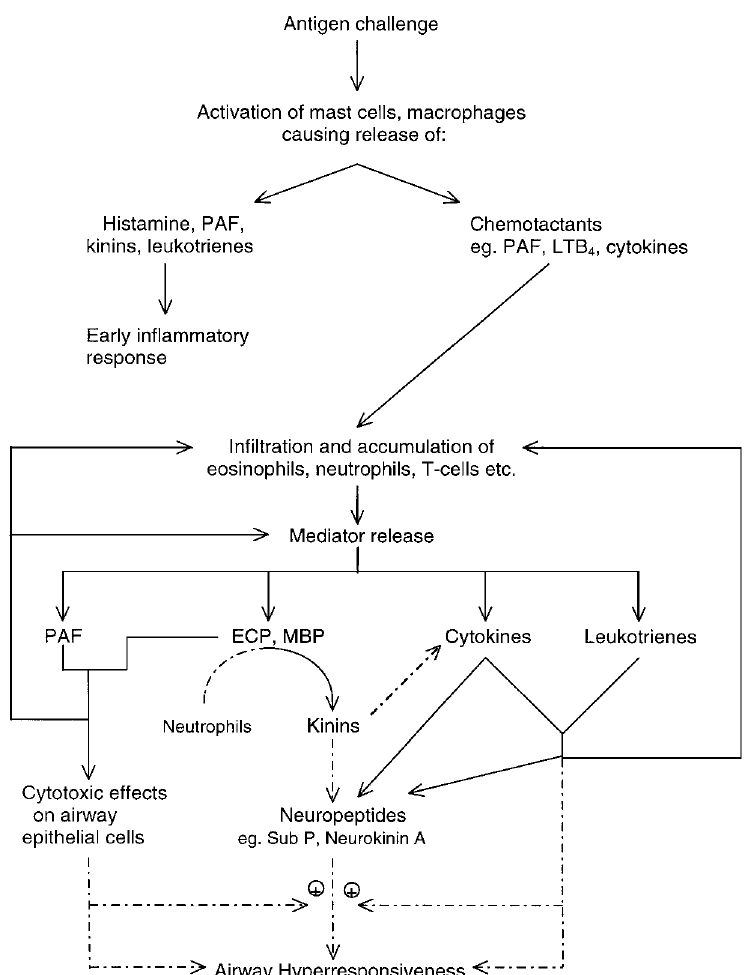
FIG. 7. Putative mechanism for the development of airway